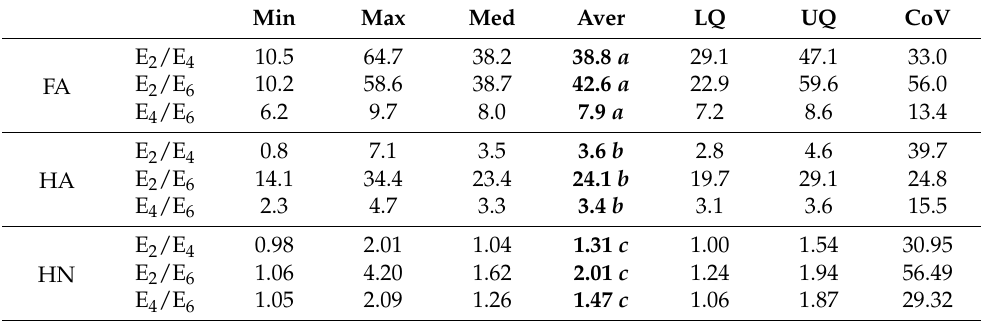
Table 3. Optical properties of individual humic substances (FA, HA, HN) (n = 30). Min Max Med Aver LQ UQ CoV E 2 /E 4 FA